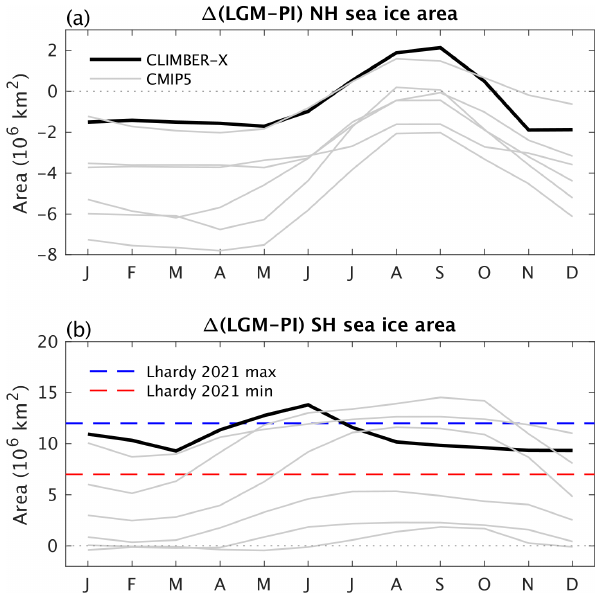
Figure 31. Difference in seasonal sea ice area in the (a) NH and (b) SH between the last glacial maximum and the pre-industrial. CLIMBER-X results (black) are compared to CMIP5 models (grey). In panel (b) the seasonal minimum and maximum changes in SH sea ice area from proxy estimates of Lhardy et al. (2021) are also